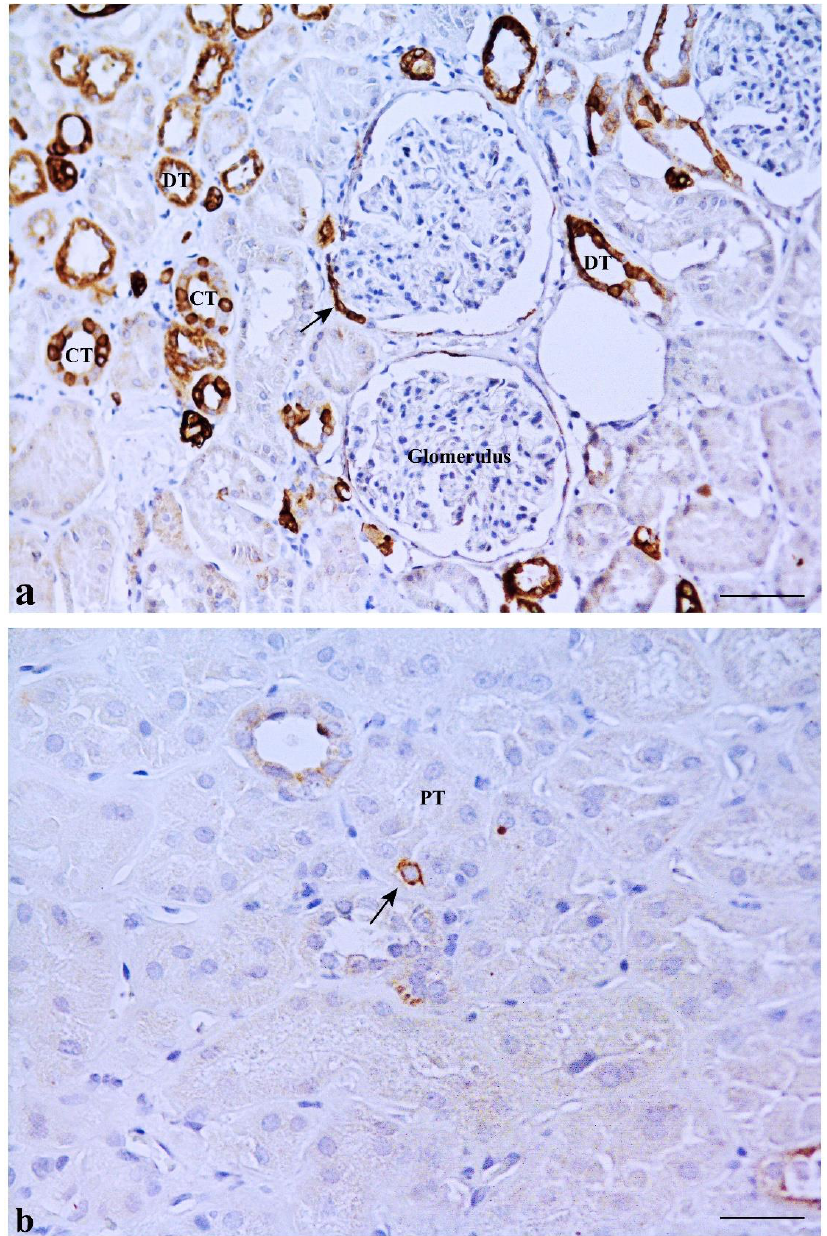
Figure 4. KRT7 immunostaining in renal tissue. ( a ) KRT7 positivity is mainly limited to distal tubules (DT) and collecting tubules (CT). Short segments of the parietal epithelium of Bowman’s capsule are rarely positive for KRT7 (arrow), while renal corpuscles are usually negative. ( b ) A single KRT7-positive cell is shown in a proximal tubule (PT) (arrow). Scale bar: 100 µm.